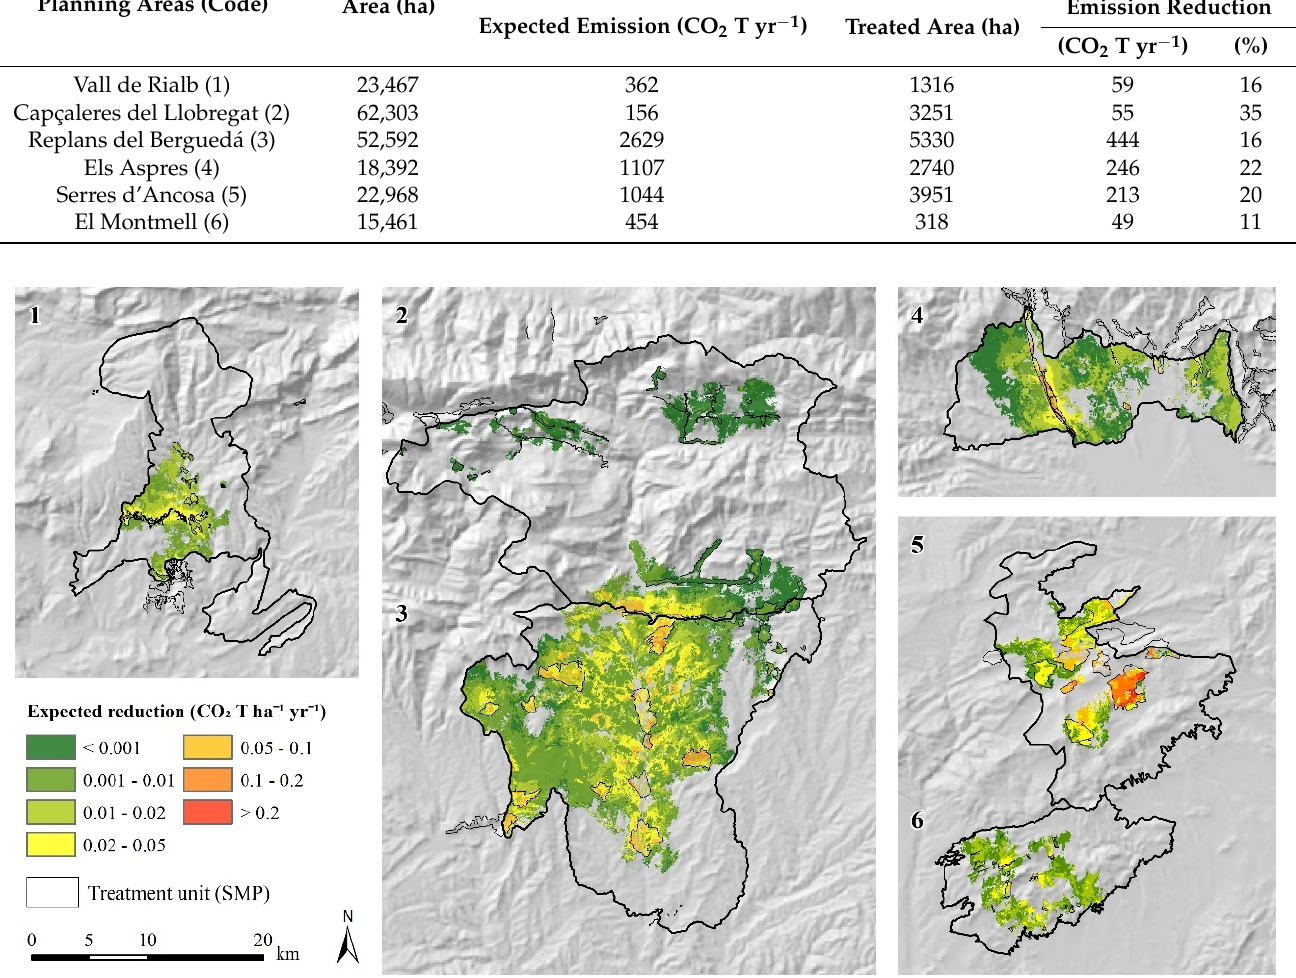
Figure 5. Reduction in carbon emissions (CO 2 T ha − 1 yr − 1 ) from wildfires occurring under extreme fire-weather conditions in diverse forest systems across the different planning areas. We located the fuel treatments in the strategic management points (Figure 2). The numbers refer to the planning area codes (Appendix A; Figure